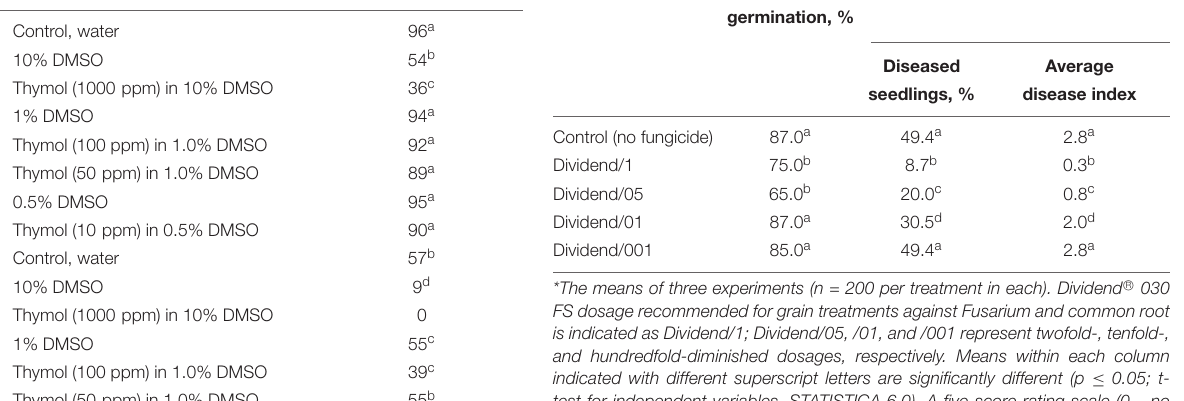
TABLE 3 | Influence of wheat and barley seed treatments with dimethyl sulfoxide (DMSO) and thymol dissolved in DMSO on seedling formation. Plant Treatments